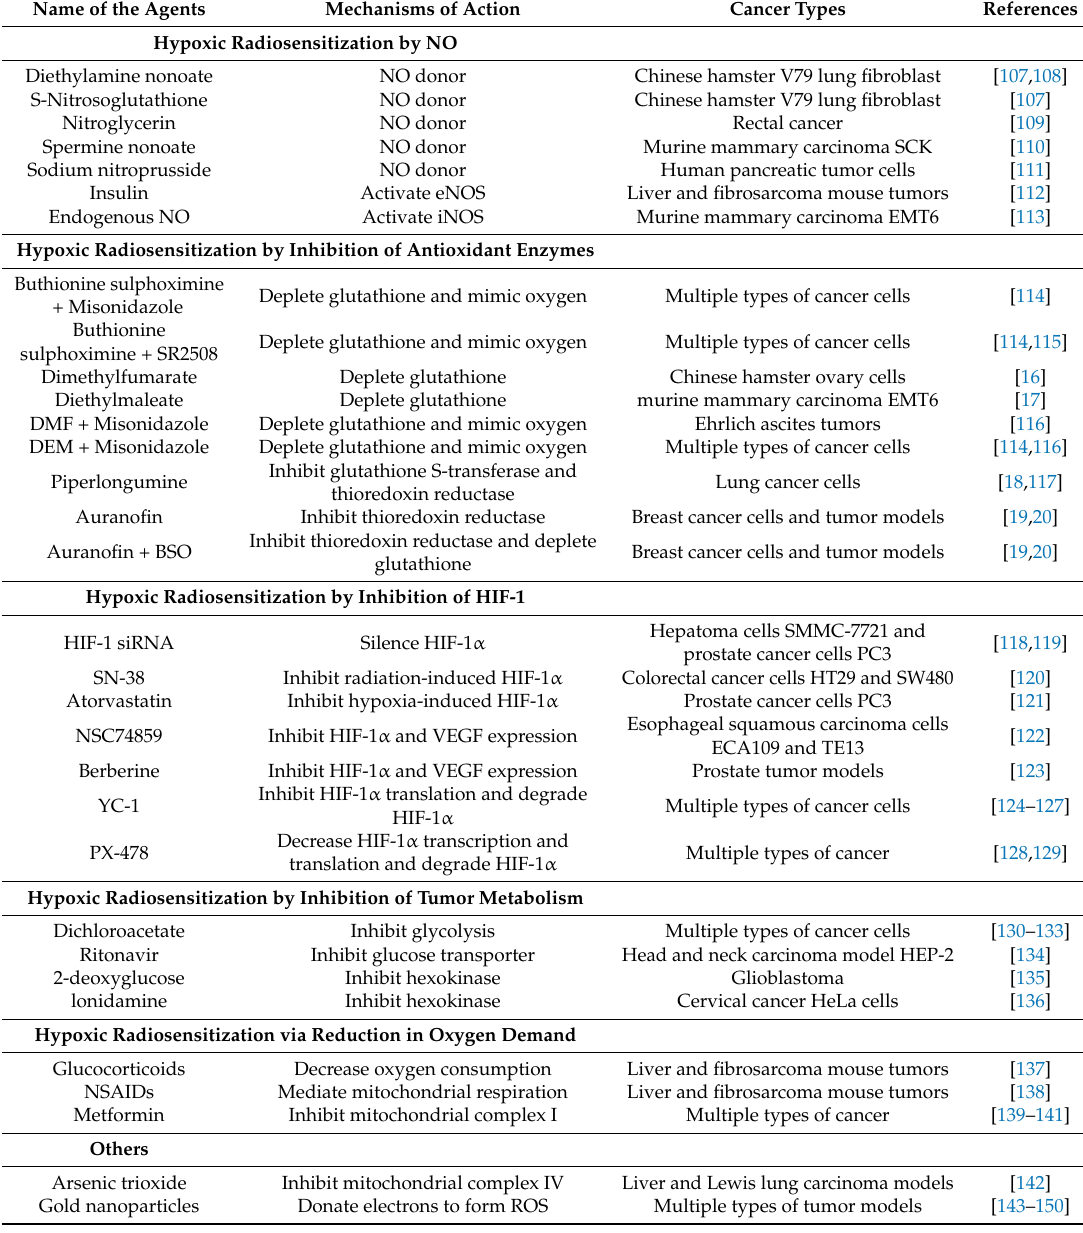
Table 2. Summary of hypoxic radiosensitizing